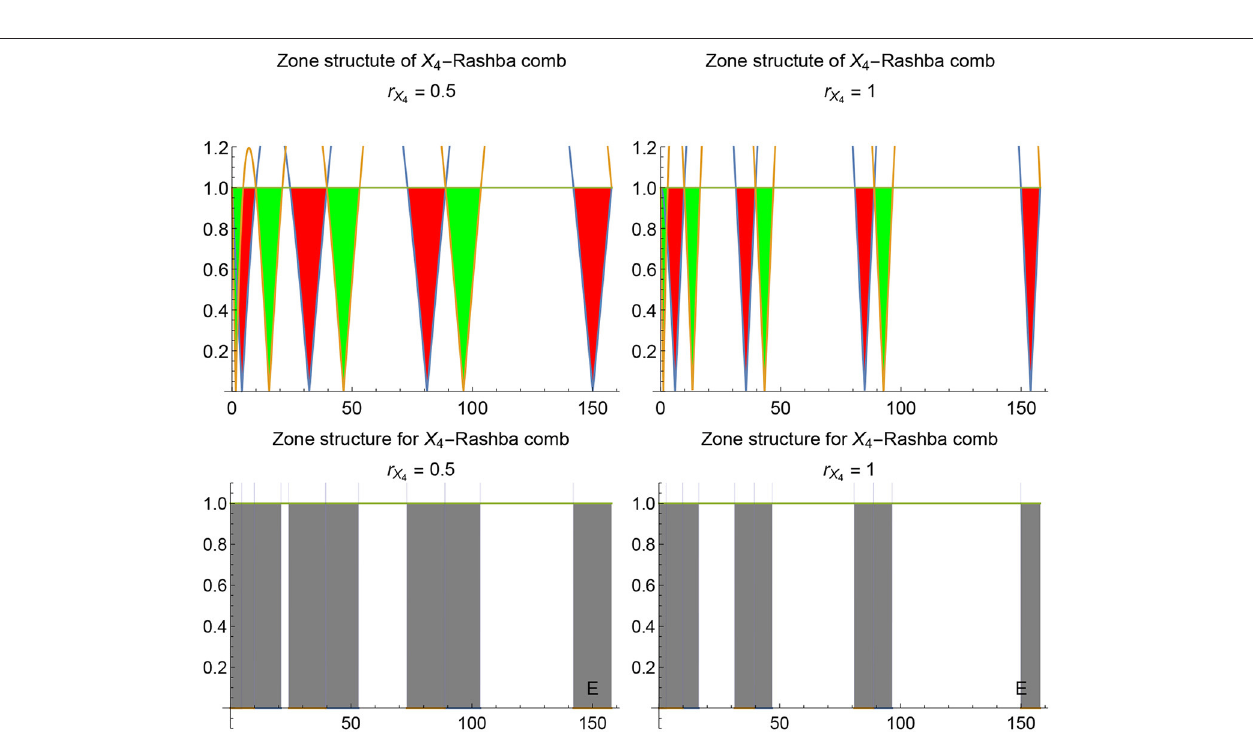
X 4 - comb. Red and green are for “minus” and “plus” branches in Eq. (27) correspondingly. FIGURE 10 | Zone structure of r −